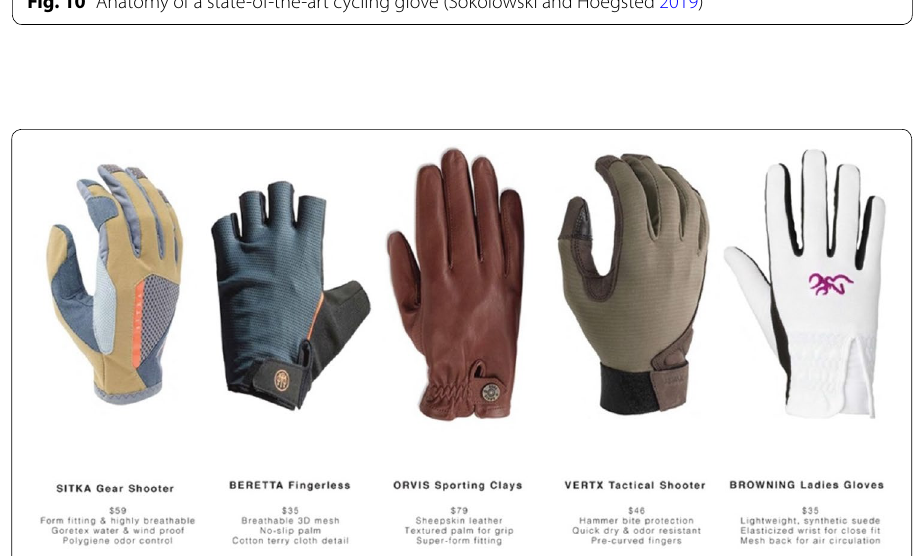
Fig. 11 Market and technology landscape for women’s clay pigeon shooting gloves (Echols 2018a)